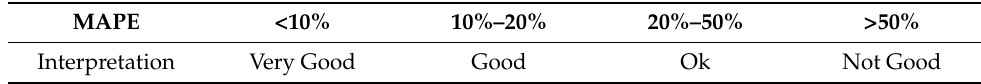
Table 3. MAPE Interpretation for Its Different Ranges in